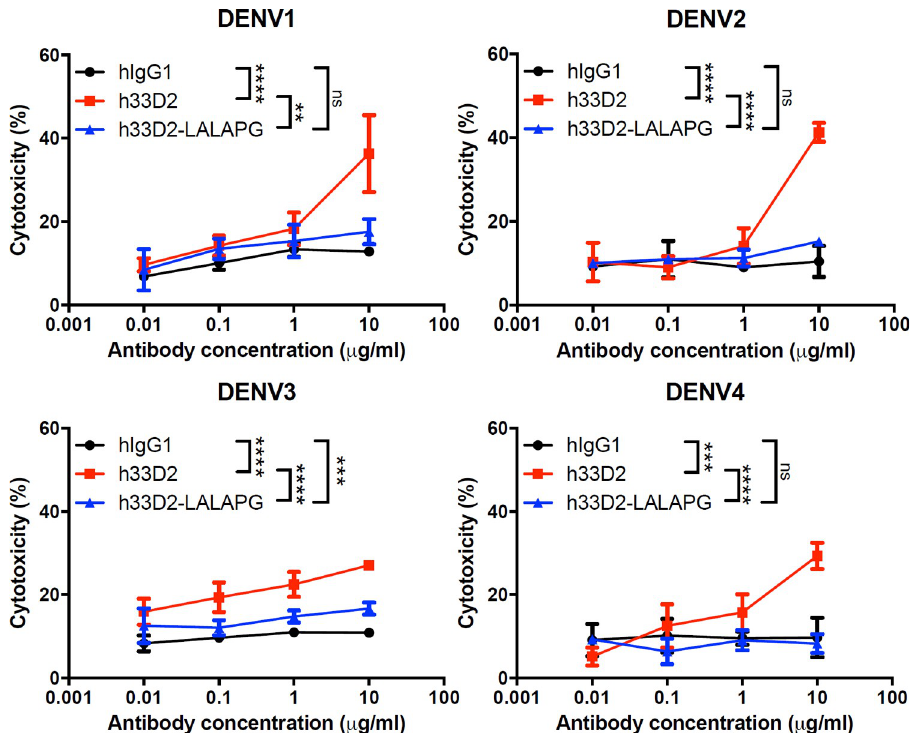
Fig 7. Fc-dependence of antibody-dependent cellular cytotoxicity of DENV-infected cells by humanized anti-NS1 mAb 33D2. Huh-7 cells were infected with DENV1-4 then using isotype control hIgG1, h33D2, and h33D2-LALAPG at 0.01, 0.1, 1, and 10 μ g/ml final concentrations to analyze ability to elicit ADCC by using NK cells. The LALAPG variant preparation and the ADCCassay were described in the methods. All data are presented as the averages of triplicate cultures ± S.D. �� : p < 0.01, ��� : p < 0.001, ���� : p < 0.0001, ns indicates not significant. Statistical significance was based on two-way ANOVA followed by Tukey’s multiple comparison